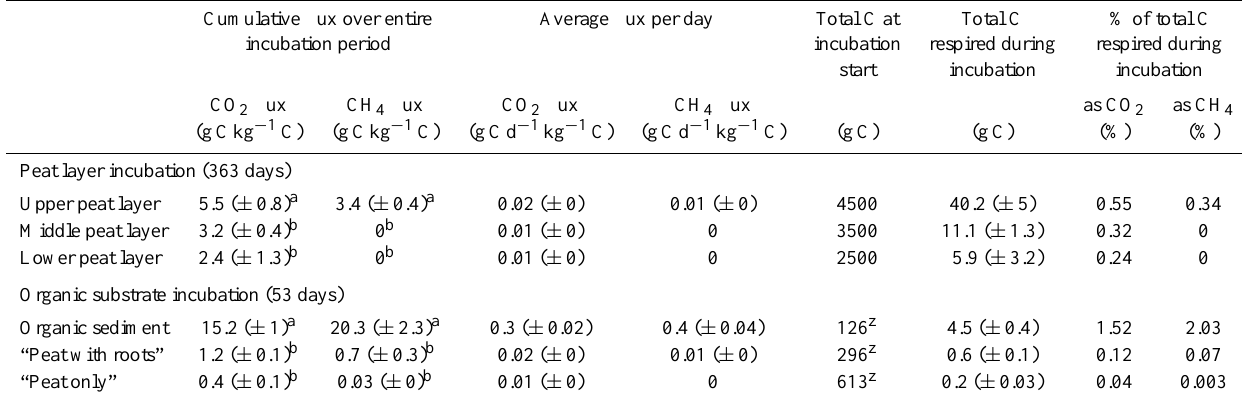
Table 4. Cumulative CO 2 and CH 4 fluxes over the incubation period (363 days for peat layer incubation; 53 days for organic substrate incubation), average per day (mean ± SD, n = 3), total C in incubation vessels and C respired during incubation (given as total C and in % of total C) (letters indicate differences between the treatments, p < 0 .